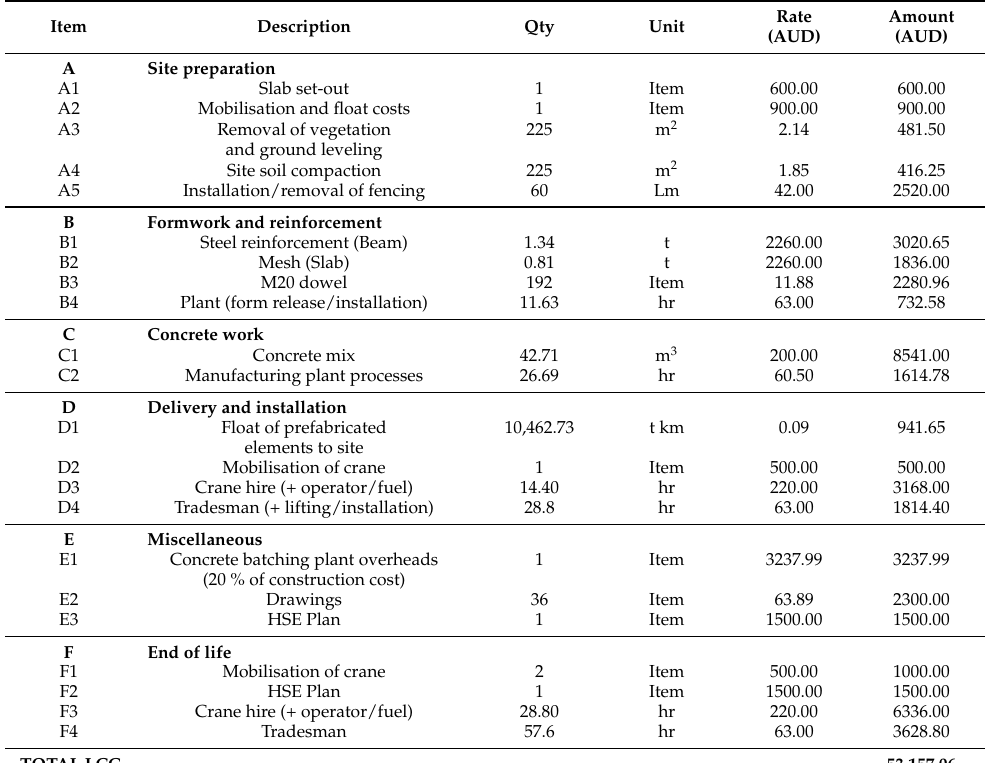
Table 4. LCC estimate for the developed prefabricated footing with a floor area, A f , of 225 m 2 on a Class H 2 /H 2 -D soil deployed for t d = 50